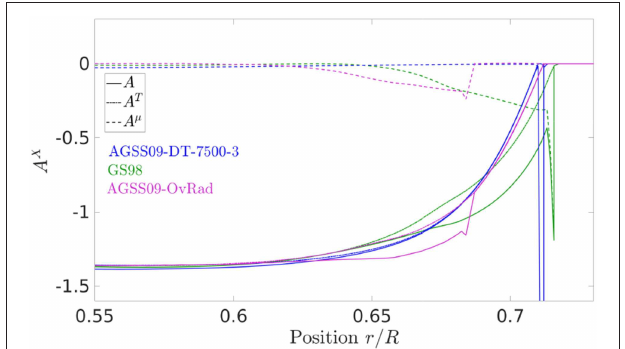
FIGURE A1 | Decomposition of the Ledoux discriminant in its thermal and chemical composition gradients contributions for a model built with the GS98 abundances, and other models including modified opacity tables and macroscopic chemical